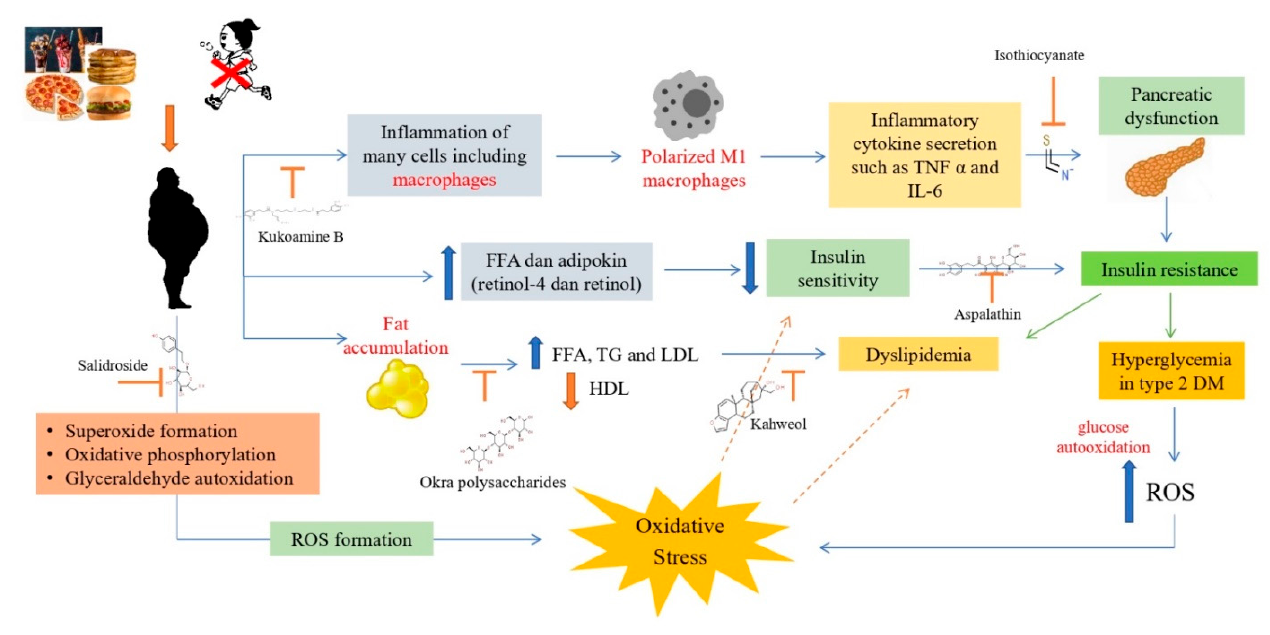
Figure 3. Antioxidant mechanisms in obesity, dyslipidemia and diabetes [100]. Obesity can cause inflammation of macrophage cells so macrophages will be polarized into M1 macrophages due to inflammation. M1 polarized macrophages will secrete inflammatory cytokines such as TNF α and cause type 2 DM with hyperglycemia, which can increase ROS, causing oxidative stress. Obesity can